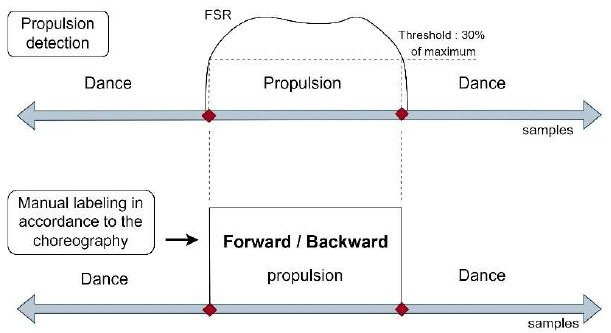
Figure 10. Semi-automatic labeling.